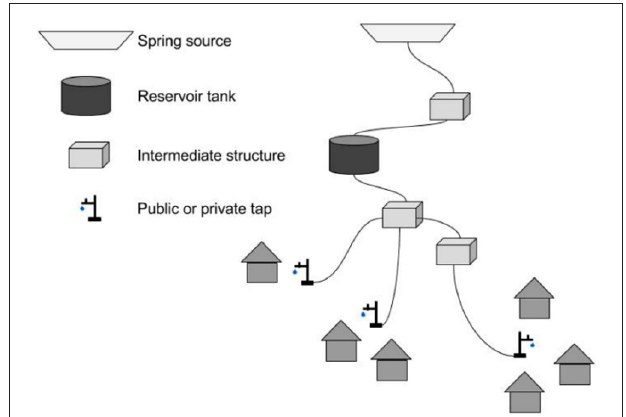
FIGURE 2 | Sketch of a typical gravity-fed piped water system or sub-system in the study area. A water source can feed one or several reservoir tanks that distribute water to different taps. The intermediate structures can be distribution, collection, purge valve, air valve or interruption chambers, or break pressure tanks (Image source: Tosi Robinson et al.,